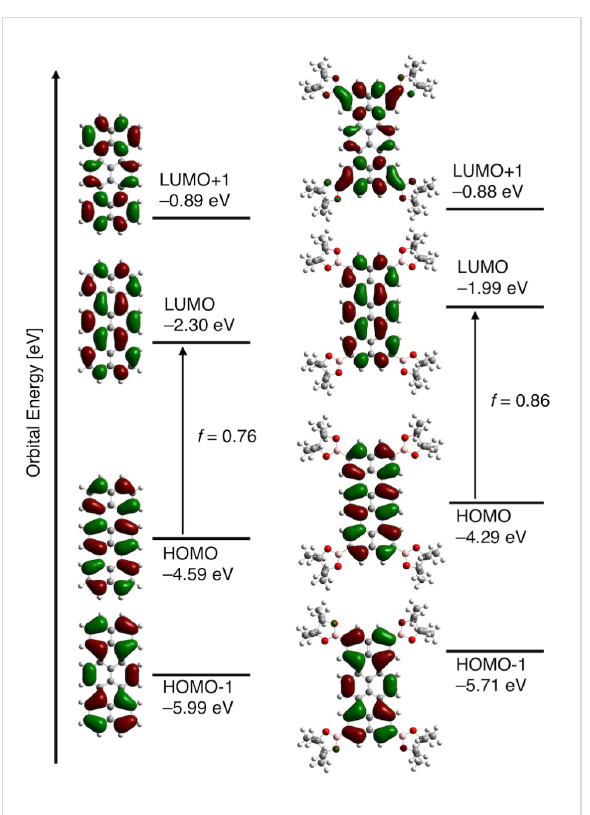
Figure 4: MO diagrams of terrylene and TB4 based on calculations at the B3LYP/6-31G(d).